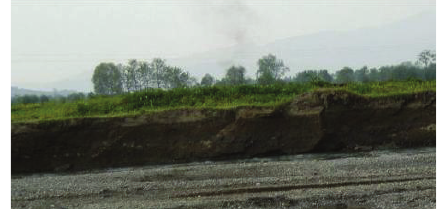
Figure 4: View of the deposits in the Duzce